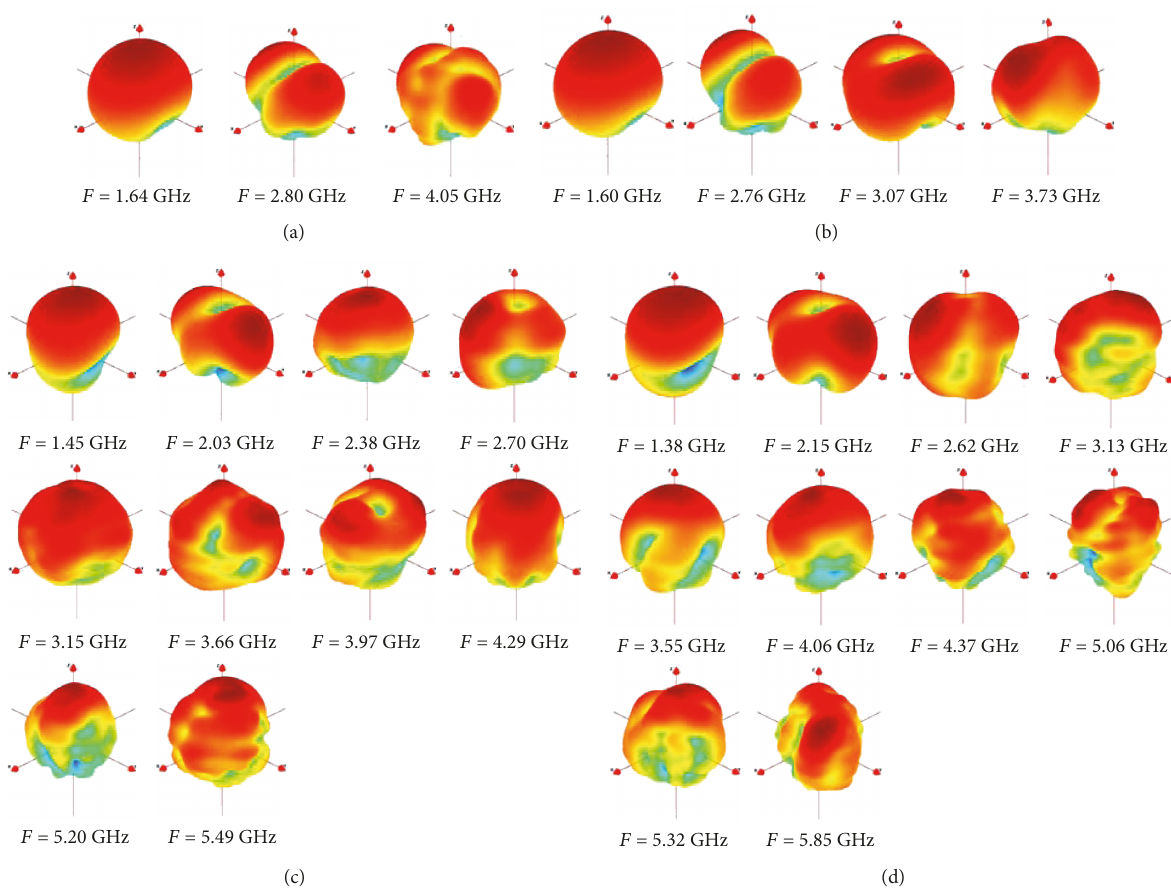
Figure 6: Measured 3D-radiation patterns at resonant frequencies for antennas: (a) A0, (b) A1, (c) A2, and (d)